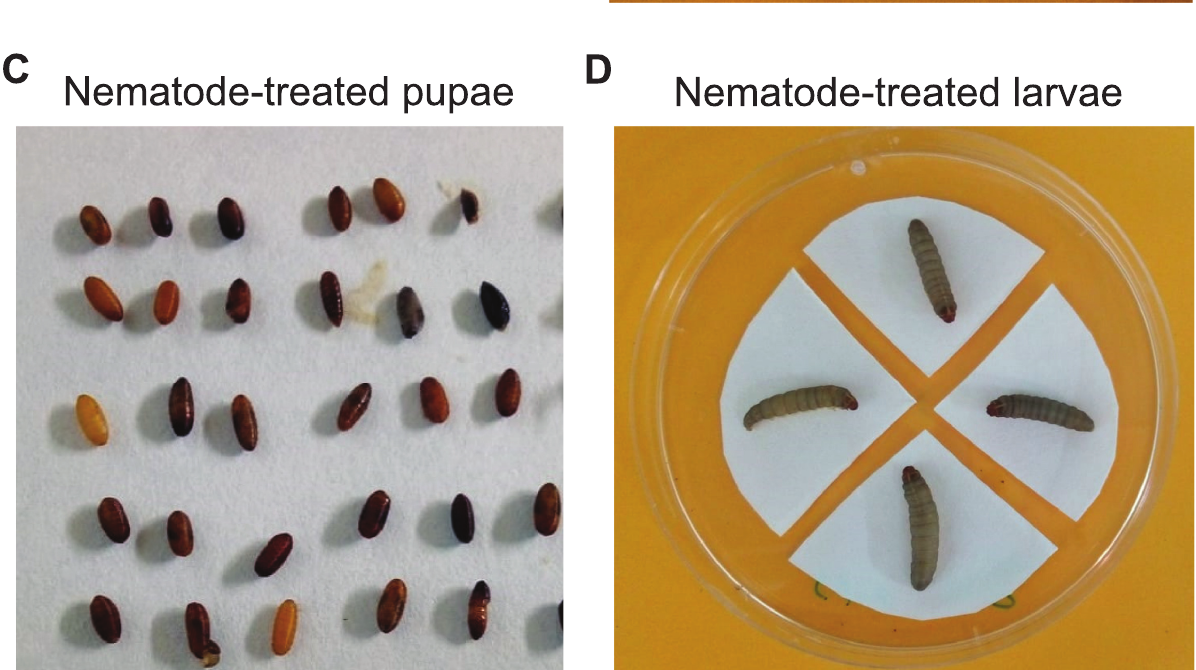
PLOS ONE | https://doi.org/10.1371/journal.pone.0269106 June 7,